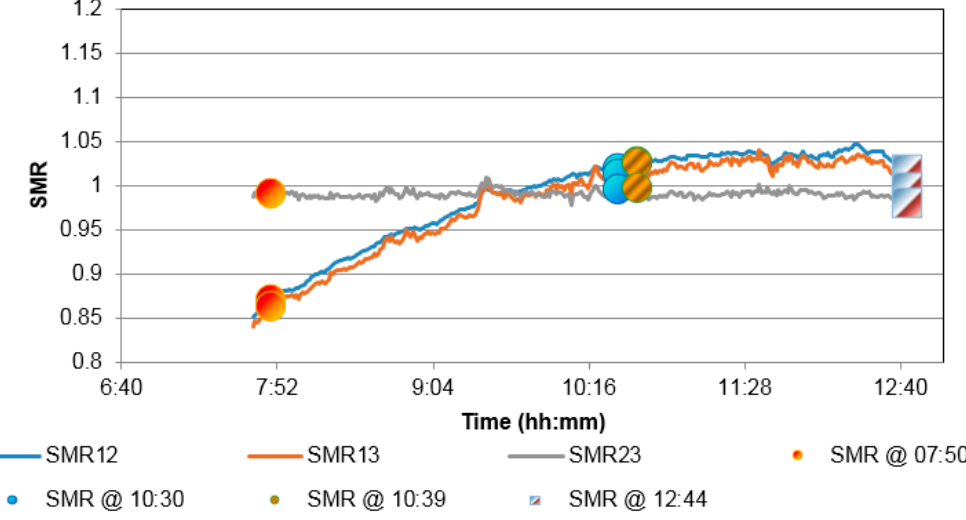
Figure 3. Spectral matching ratios during the day, calculated using the measured spectra and spectral responses without any added error. The four triplets of spectral matching ratios (SMR) given by the spectra used in this study are highlighted.